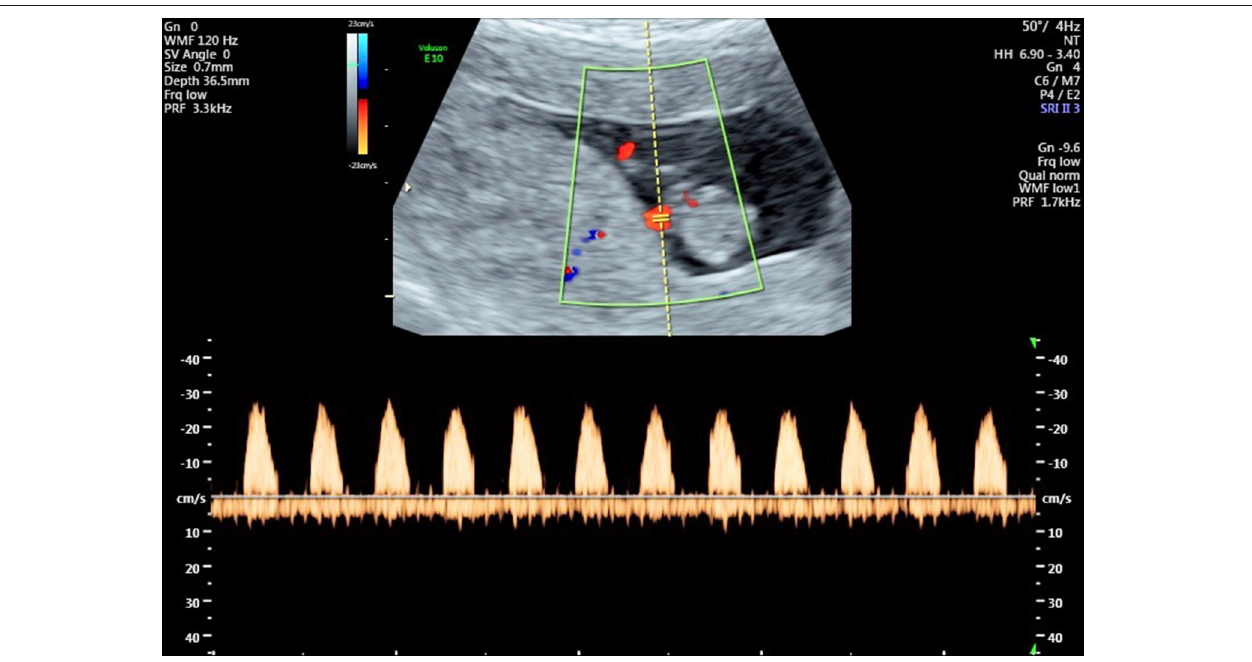
FIGURE 4 | Flow velocity waveforms from the umbilical artery at 10 weeks and 6 days showing the absence of end-diastolic flow in all cardiac cycles.